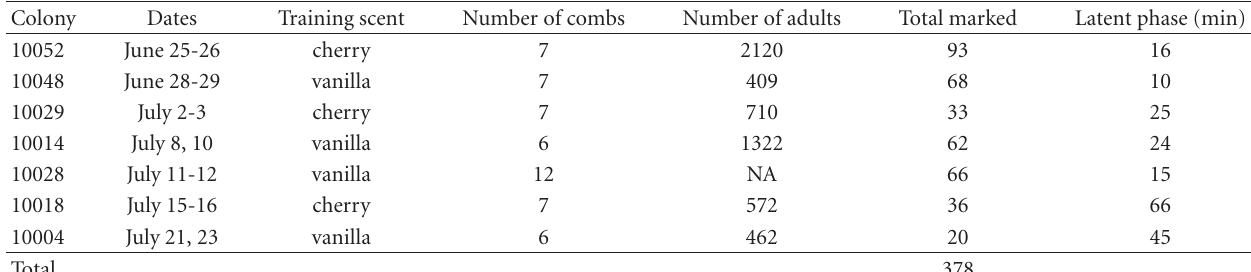
Table 1: Colony information. For each colony the following are indicated: the colony identification number, dates on which foragers were marked and tested, training scent used, number of combs in the nest, number of adults present at collection (within 36hrs of end of experiment), total number of foragers marked during the training-marking phase, and the duration of the latent phase. Colony 10028 absconded before it was collected, so it was not possible to count the number of adults on the nest.